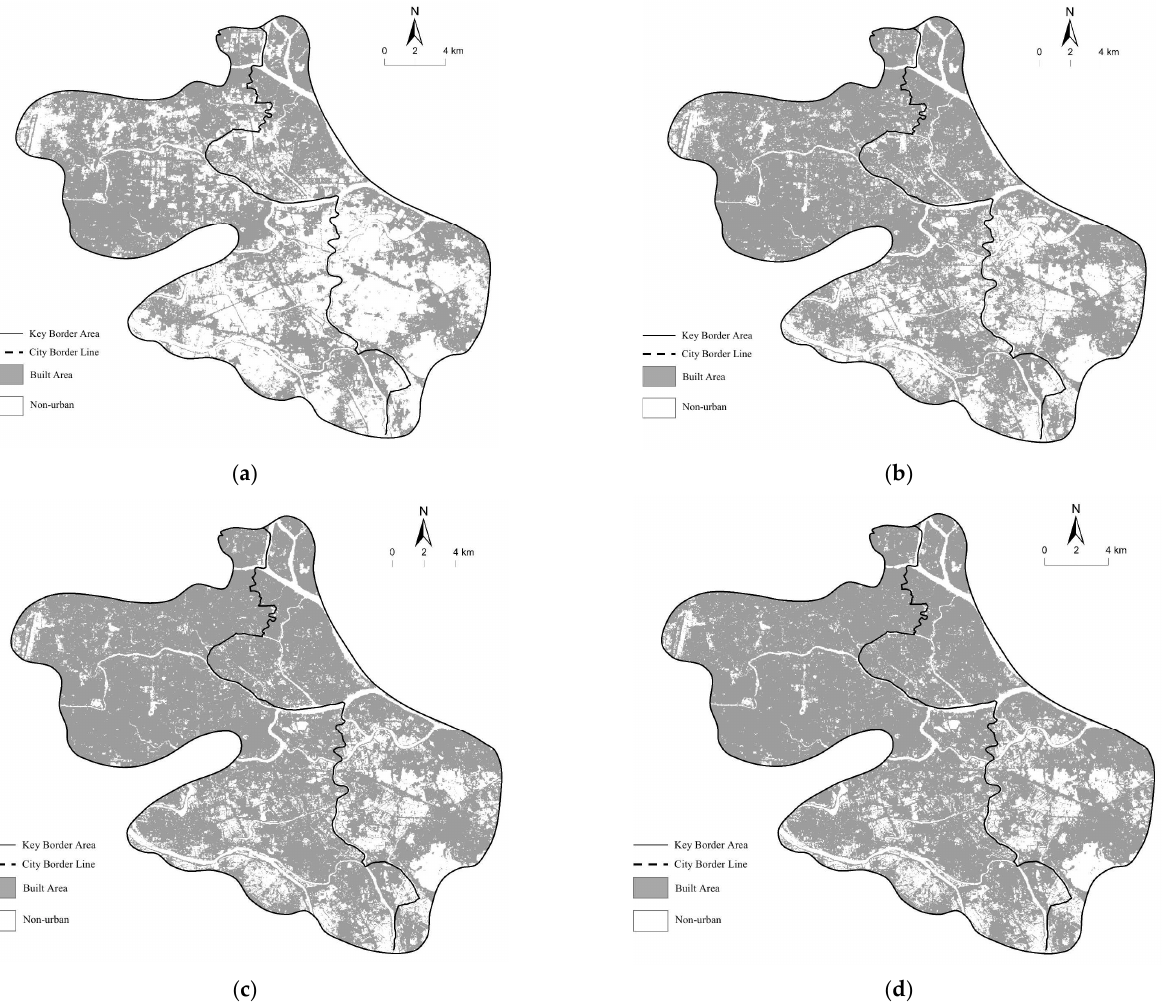
Figure 10. Spatial growth evolution, 2005–2020. ( a ) Spatial growth in 2005; ( b ) Spatial growth in 2010; ( c ) Spatial growth in 2015; ( d ) Spatial growth in 2017.